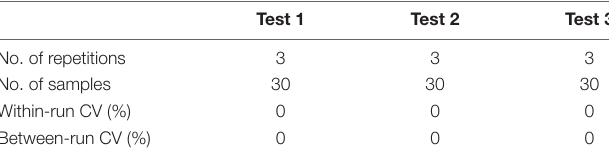
TABLE 4 | Statistical results of repeatability with the real-time recombinase-aid amplification (RAA) assay. Test 1 Test 2 Test